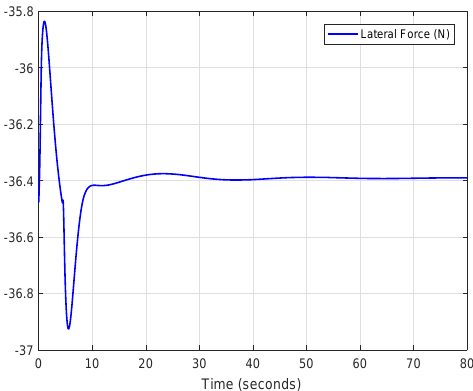
Figure 36. Wind force on the vehicle for the controller with variable band and optimal reset in